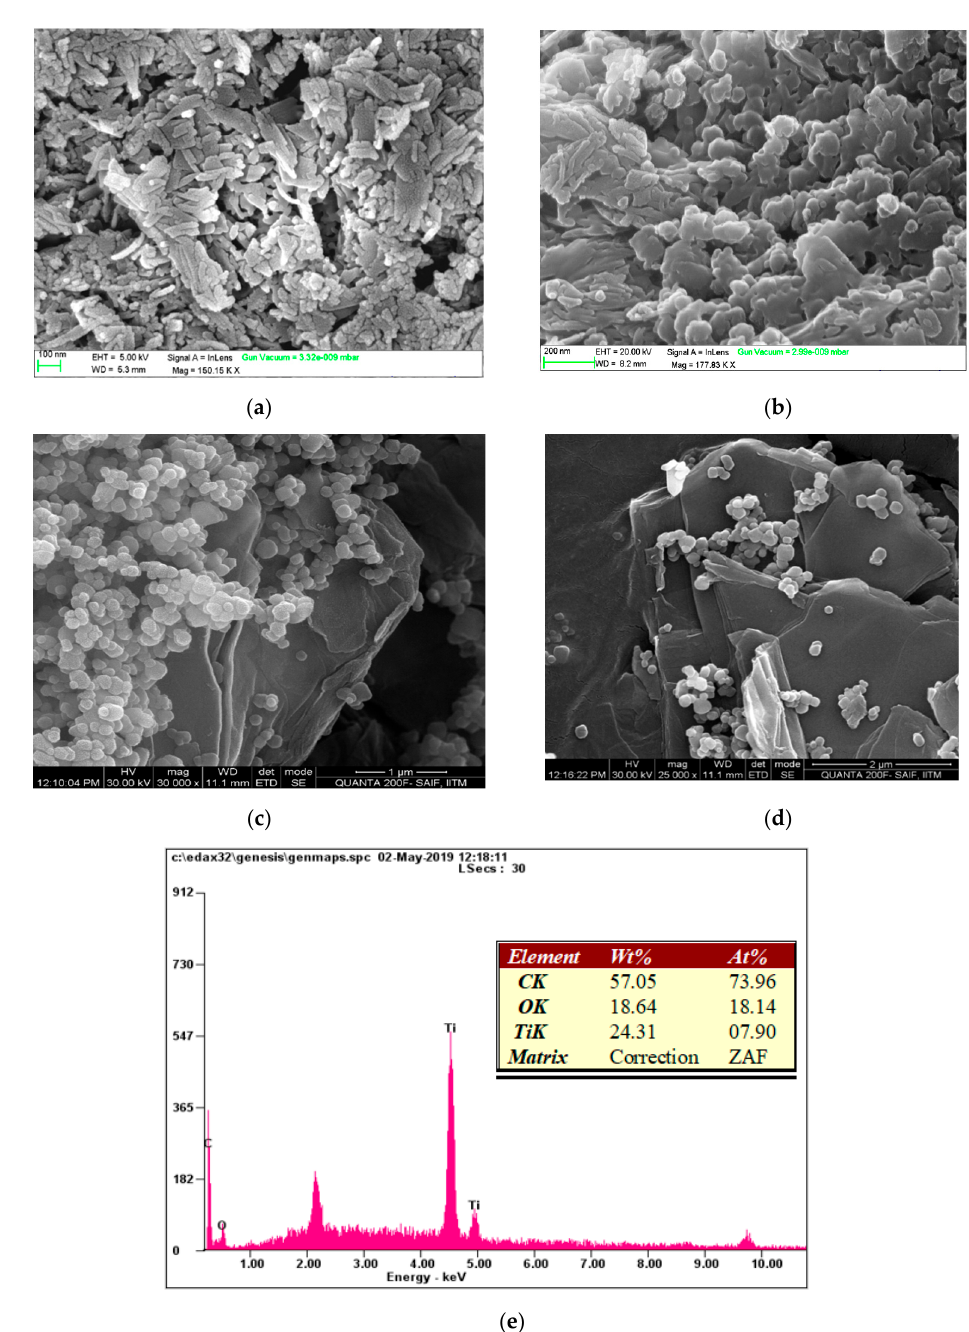
Figure 1. ( a , b ) FESEM images of TiO 2 nanospheres. ( c , d ) FESEM images of rGO/TiO 2 nanocomposites, ( e ) EDX Spectrum of the rGO/TiO 2 nanocomposites with the chemical composition (inset).